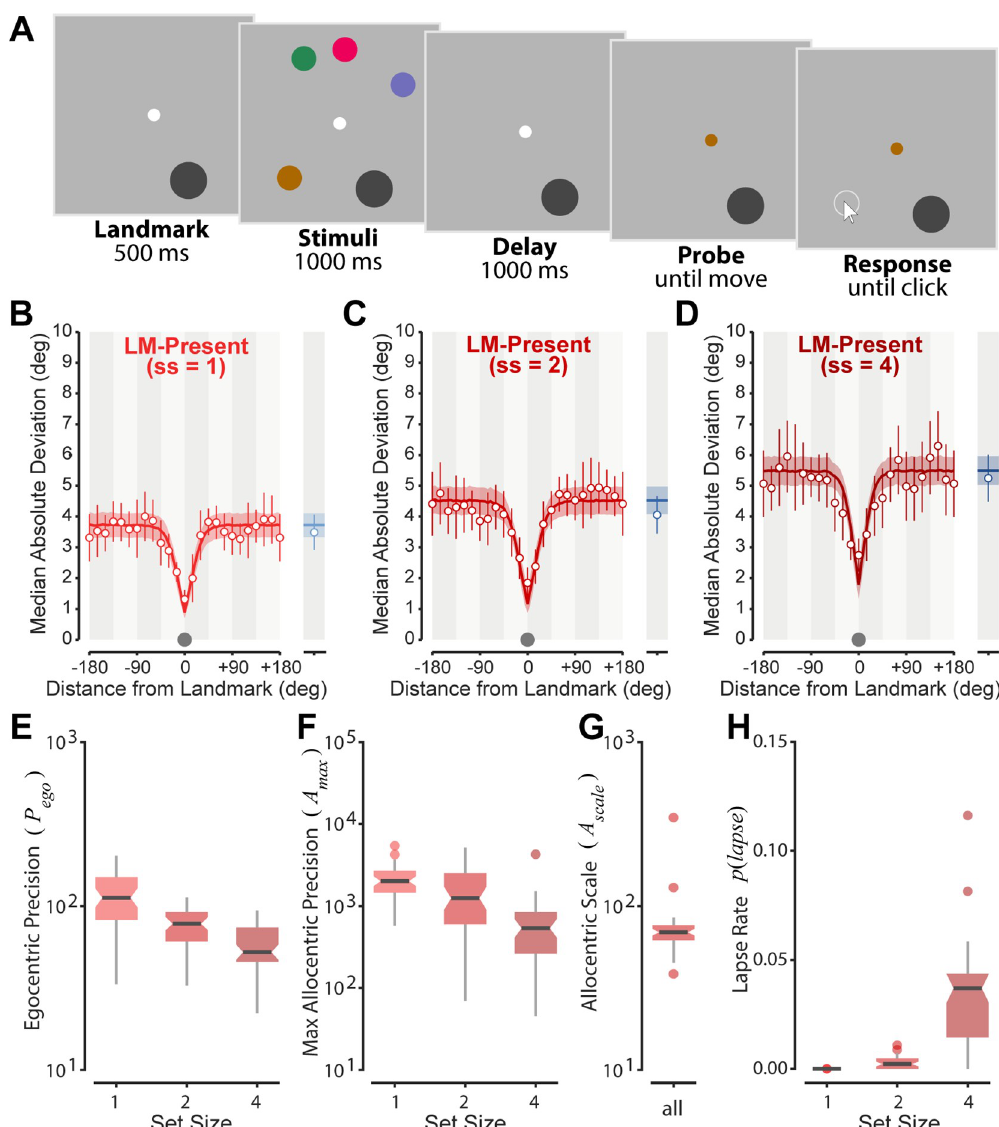
Fig 1. Experiment one. (A) LM-PRESENT design. Participants memorized the locations of colored disks in the presence of a landmark (a larger dark gray disk; note object sizes are exaggerated for visibility). (B-D) Data points indicate mean variability in location recall for set sizes 1, 2 and 4 respectively, with predictions of the optimal integration model overlaid (colored lines). Note the model captures both the reduction in variability near the landmark, and the plateau in variability at far landmark-target separations. LM-PRESENT data is shown in red, LM-ABSENT in blue. Errorbars and patches indicate 95% CI. Gray dots indicate size of the landmark on the x-axis scale. (E-H) Box plots depicting parameter estimates for the best- fitting model (notch represents 95% confidence interval on the median). Note the decrease in egocentric precision (E), decrease in allocentric precision (F) and increase in lapse rate (H) associated with increasing set size, while the best-fitting model exhibited no changes in the allocentric scale (rate of decay with distance), which is therefore estimated by a single parameter (G).